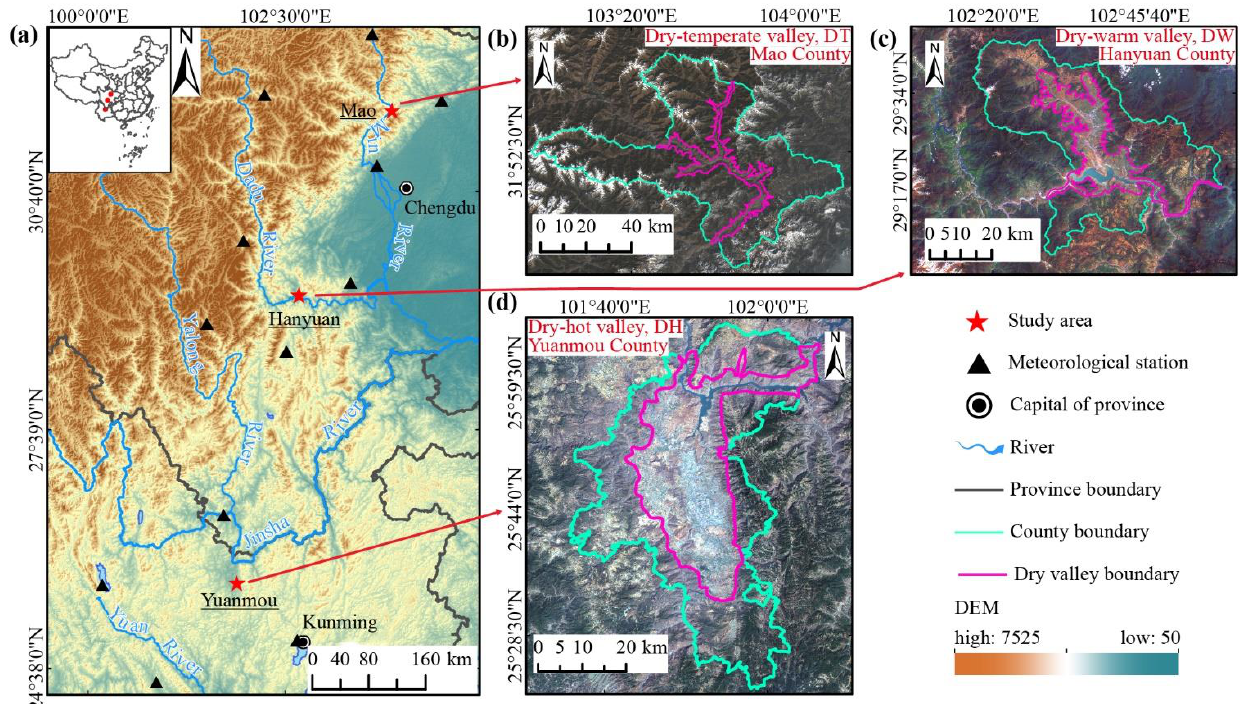
Figure 1. ( a ) Map showing location of the study area, and three Landsat images showing ( b ) dry–temperate (DT) valley in Mao County, ( c ) dry–warm (DW) valley in Hanyuan County, and ( d ) dry–hot (DH) valley in Yuanmou County.